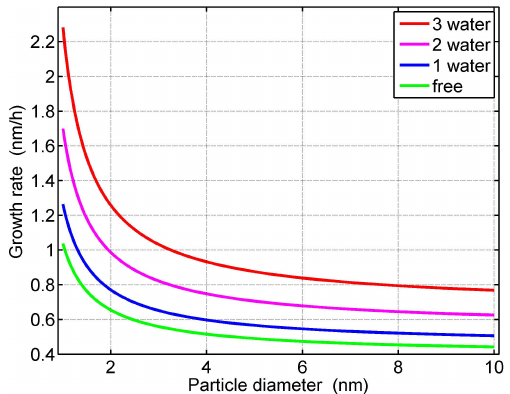
Fig. 4. Particle growth rate according to Eq. (5) as a function of par- ticle size and molecular properties of the condensing vapor. Vapor concentration is 10 7 cm − 3 , and saturation vapor pressure is neg- ligible. The vapor properties of free sulphuric acid and hydrated sulphuric acid molecules with one, two or three water molecules are